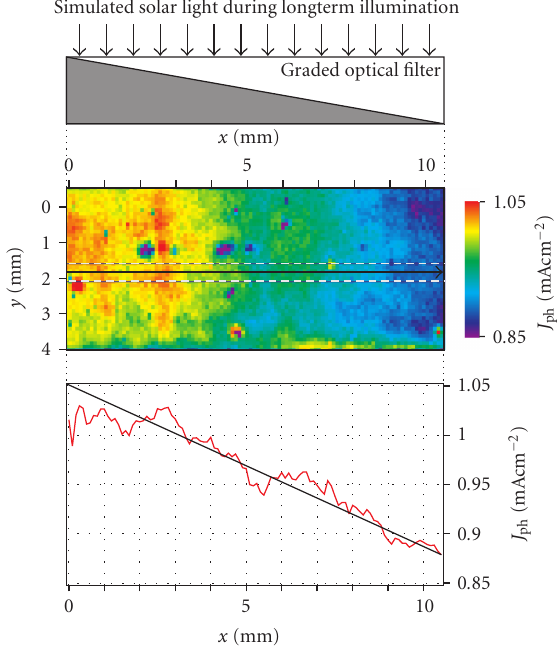
Figure 8: Nanocrystalline TiO 2 -N3 sensitized solar cell with graded filter placed on its surface after 1245 hours of exposure to simulated solar light. It is seen that photodegradation, measured as spatially resolved photocurrent output, is proportional to solar light intensity and thus the photocurrent passed.